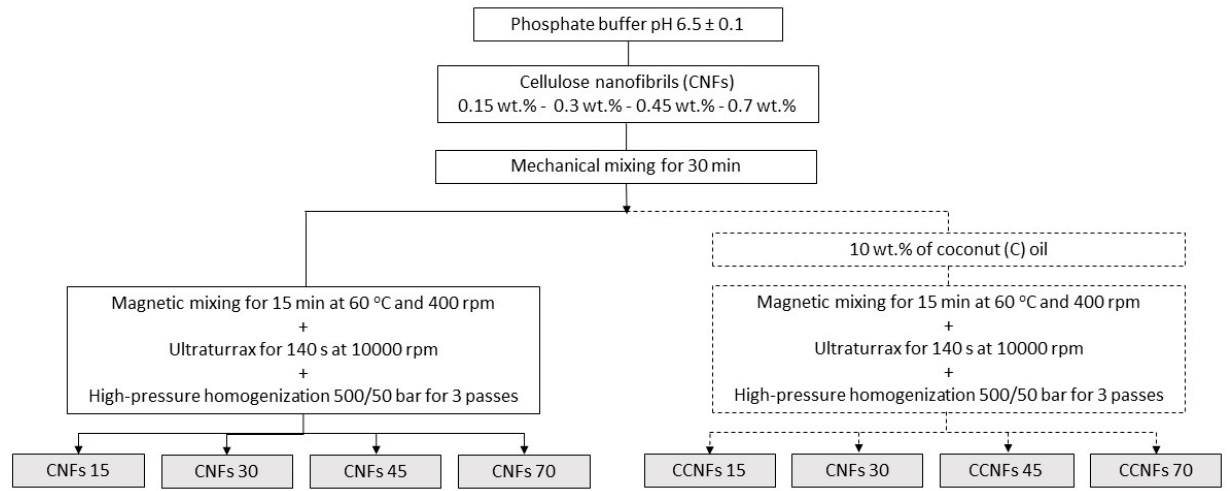
Figure 1. Scheme of the processing of suspensions of CNFs without oil and of emulsions of CNFs with coconut oil. CNFs contents of 0.15, 0.3, 0.45 and 0.7 wt.% were evaluated. Oil-free suspensions are CNFs15, CNFs30, CNFs45 or CNFs70, respectively. Emulsions with CNFs and coconut oil are CCNFs15, CCNFs30, CCNFs45 and CCNFs70.